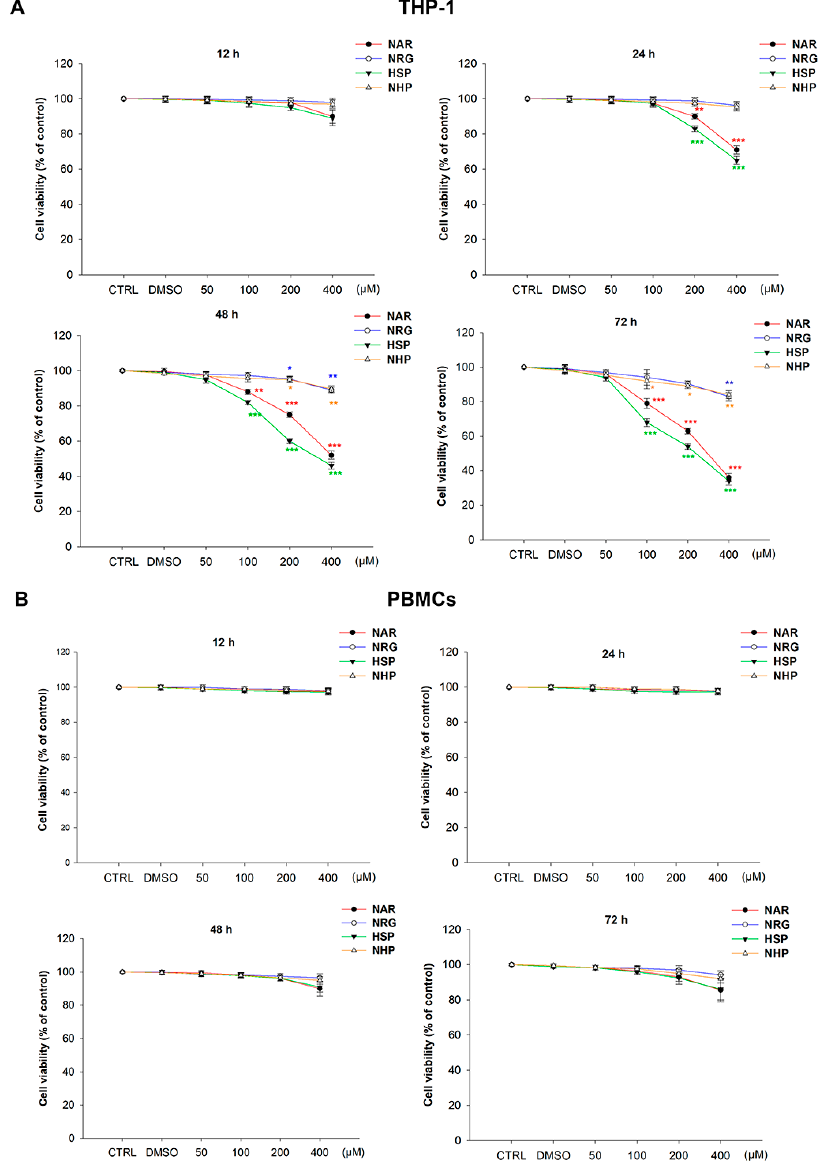
Figure 4. Effects of NAR, NRG, HSP, and NHP (50–400 µM) in THP-1 ( A ) and PBMCs ( B ) cell proliferation. Viability rate was assessed by resazurin assay. Results are expressed as percentages ± SEM of the fluorescence values detected with respect to those of the control (CTRL) cells. Each concentration was tested eight-fold, and three independent experiments were carried out ( n = 24). * p < 0.05, ** p < 0.01, and *** p < 0.001 vs. CTRL.